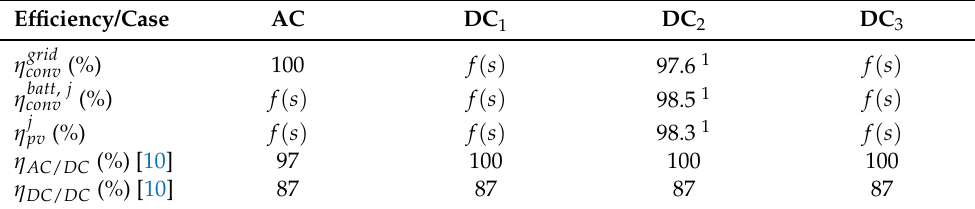
Table 2. Efficiency characteristics used for system modelling in each of the four cases.